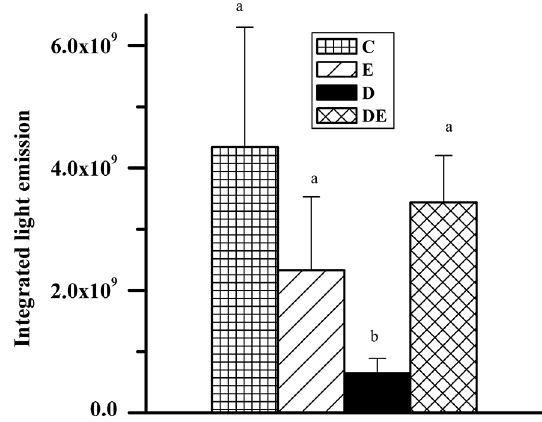
FIGURE 4 - Effect of the Passiflora edulis leaf ethanolic extract on Reactive Oxygen Species (ROS) production in diabetic and non-diabetic rats. The values are represented as the means ± SD of the four-five experiments of the integrated light emission area that was obtained for luminol oxidation (1 mmol.L –1 ) promoted by Candida albicans (1x10 7 cells per test)-stimulated rat peritoneal macrophages (1x10 6 cells per test) from control animals (C), diabetic animals (D), Passiflora edulis ethanolic extract-treated non-diabetic animals (E) and Passiflora edulis ethanolic extract-treated diabetic animals (DE). Different letters indicate statistical significance